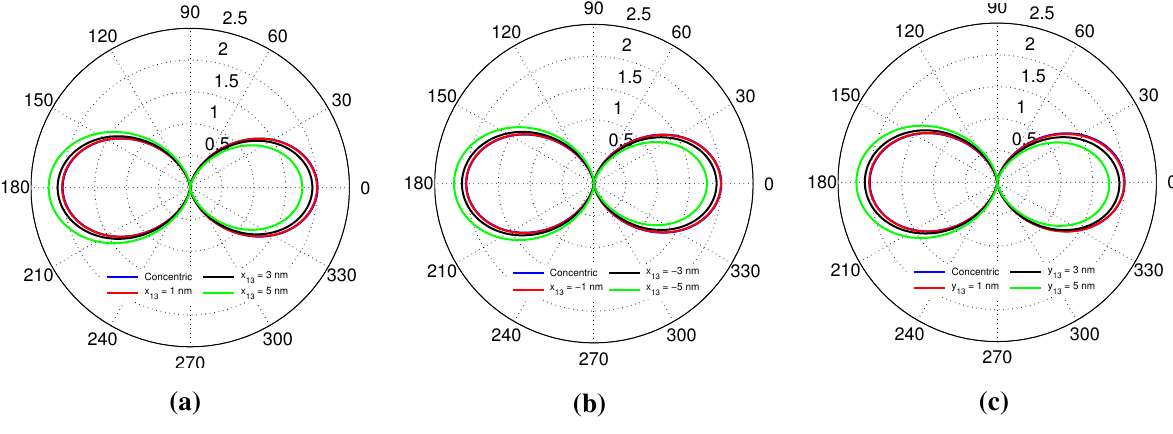
Figure 8. The directivity of the concentric and eccentric 3L NPs for κ = − 0 . 4409 at the longer wavelength around 539 nm where the dipole mode dominates. The directivity is shown for core displacements along ( a ) the positive and ( b ) the negative x the positive y -axis for 1, 3 and 5 1